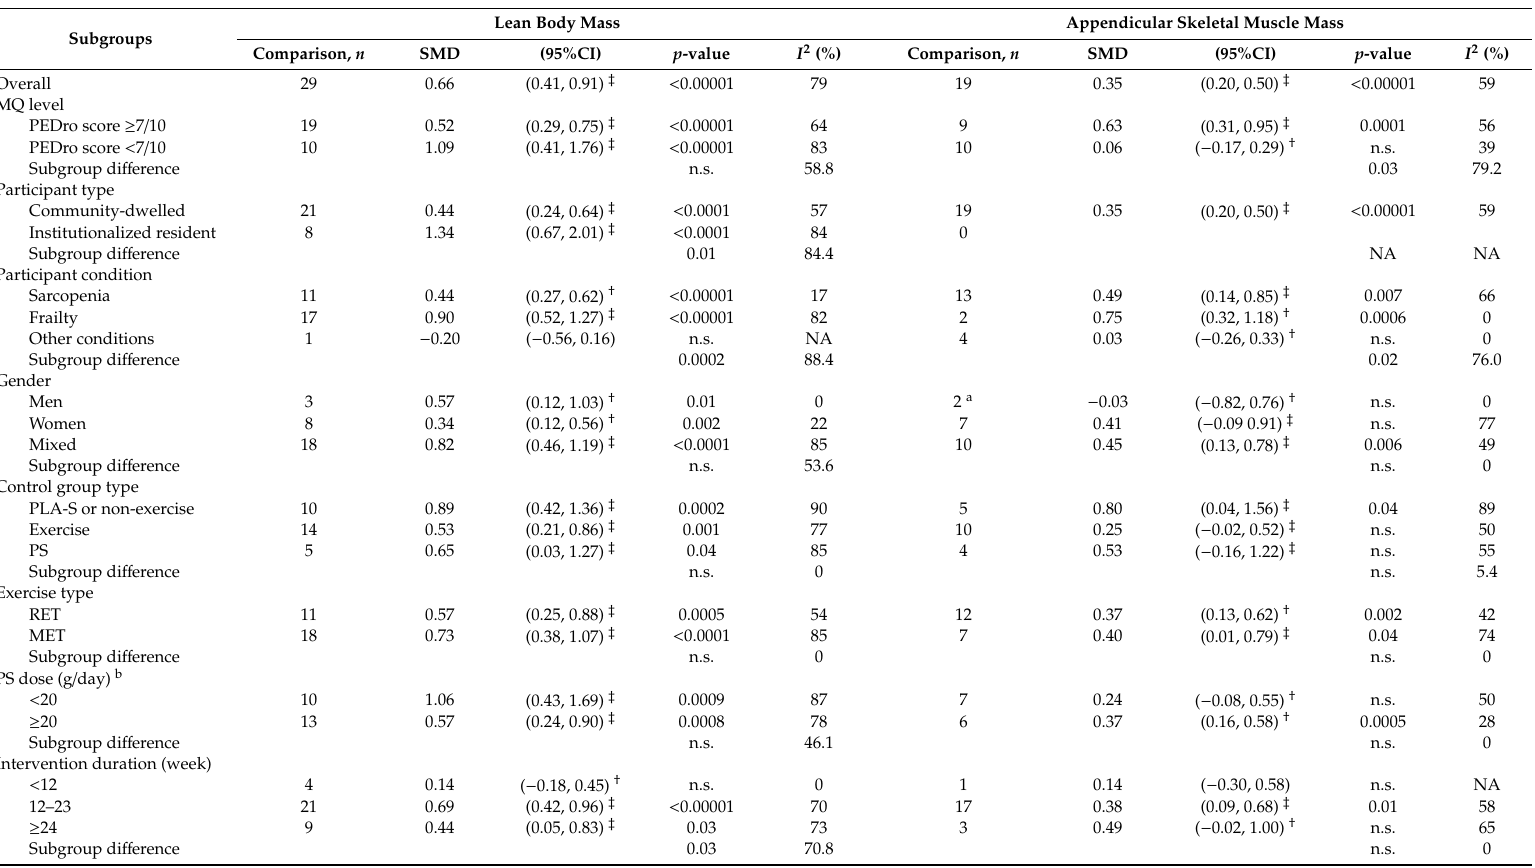
Table 3. Summary of overall e ff ects and subgroup analyses results for muscle